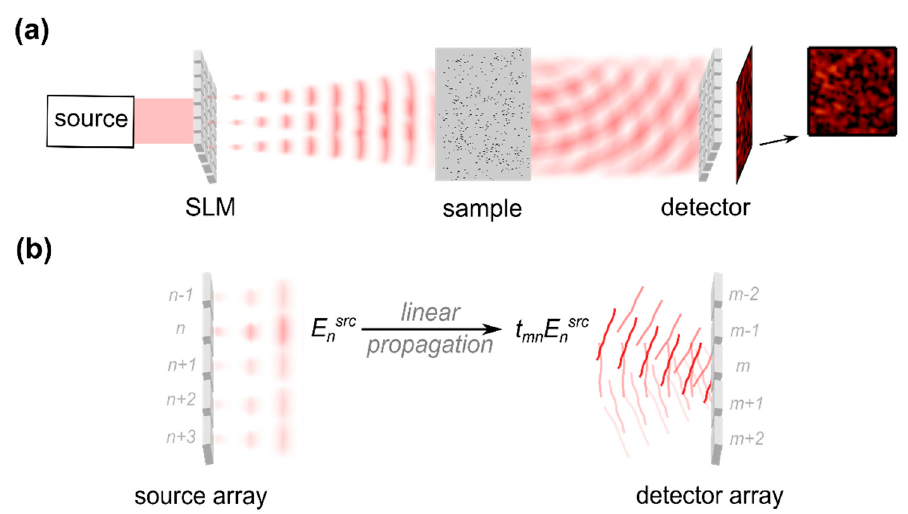
Figure 5. Principle of the optical transmission matrix. ( a ) The beam incident on a scattering sample is modulated by a spatial light modulator (SLM). In case of monochromatic radiation, a speckle pattern is observed behind the sample. ( b ) The field reflected from the SLM is considered to be composed of a number of independent sources indexed n . Since propagation in the sample is linear, the field observed at the m -th detector pixel can be described based on the incident field E src n and the static and complex-valued transmission matrix t mn ; see Equation (2) [48]. Image from [8], with